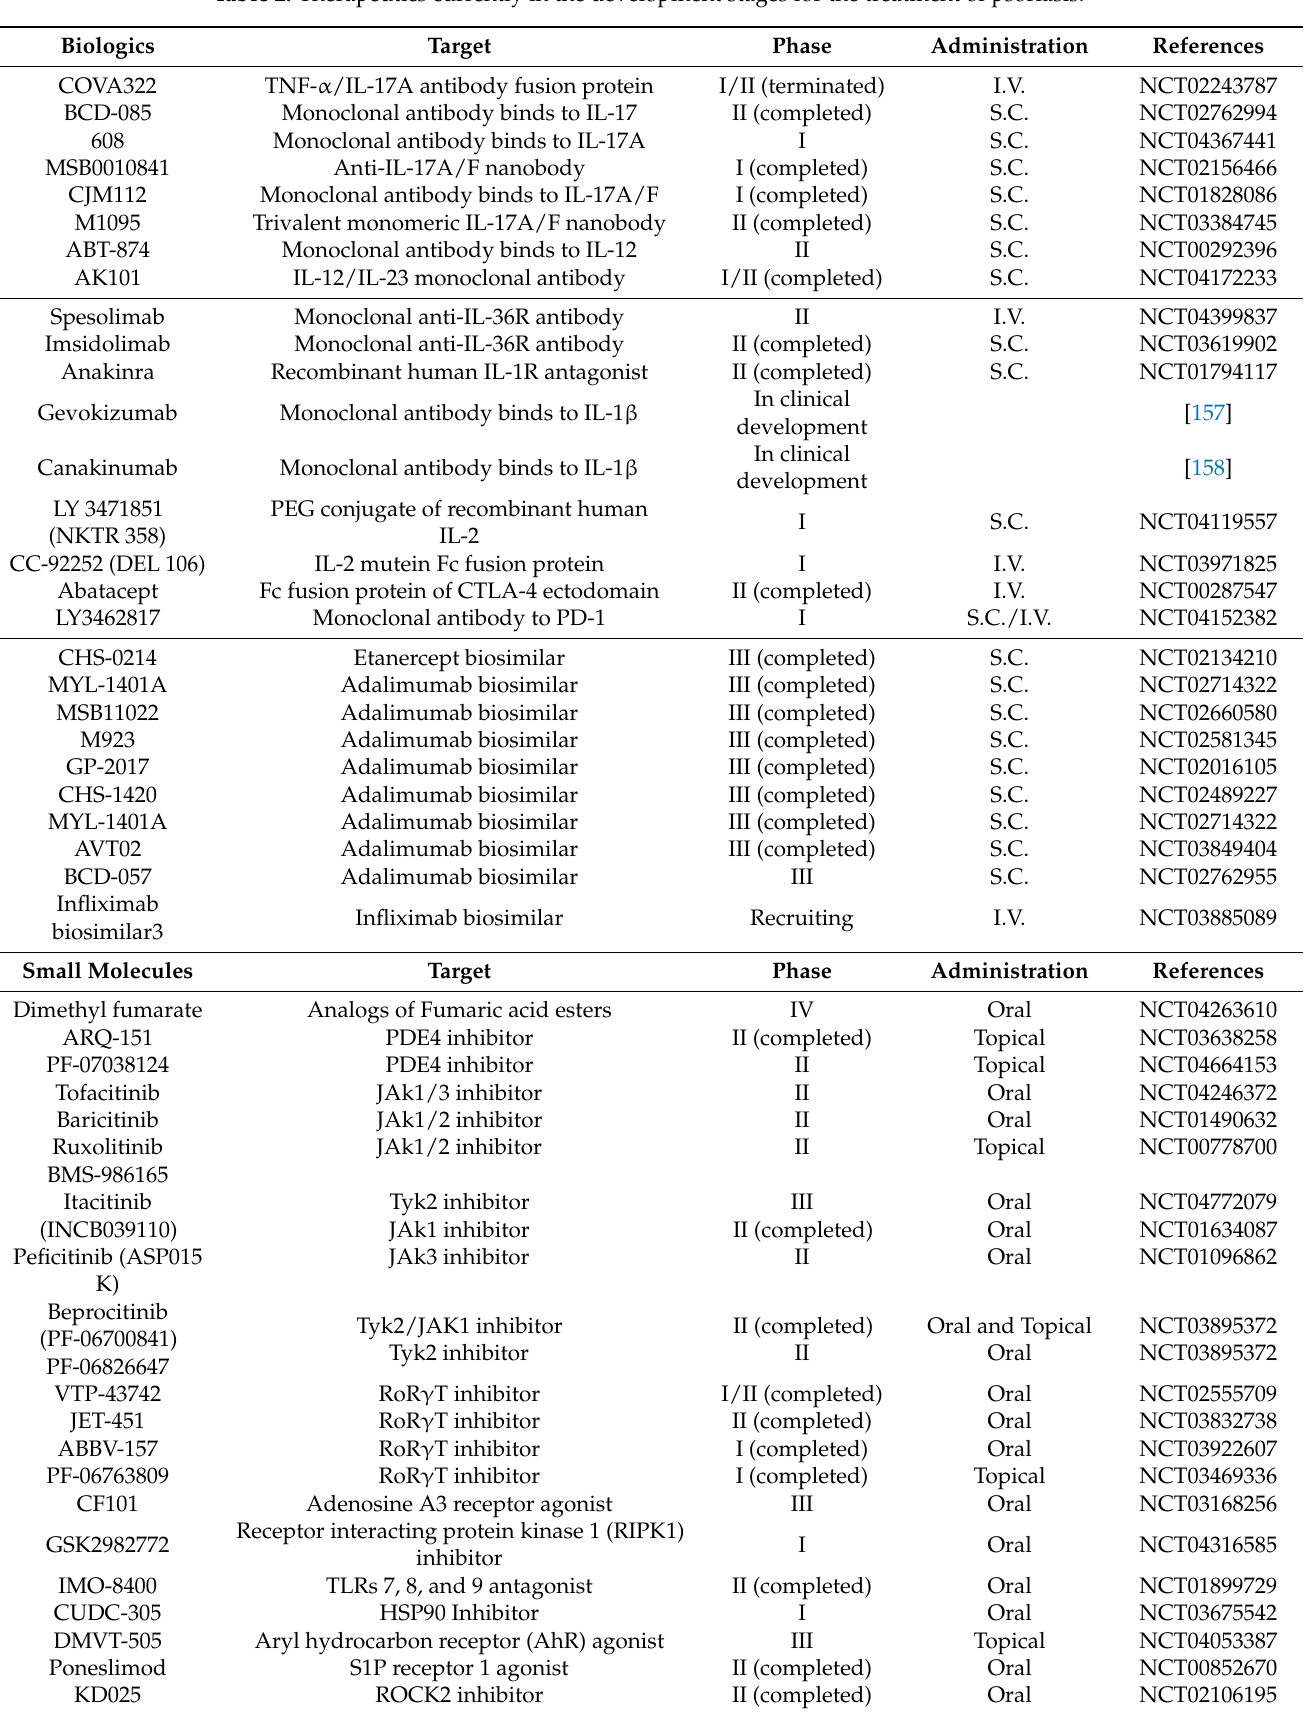
Table 2. Therapeutics currently in the development stages for the treatment of